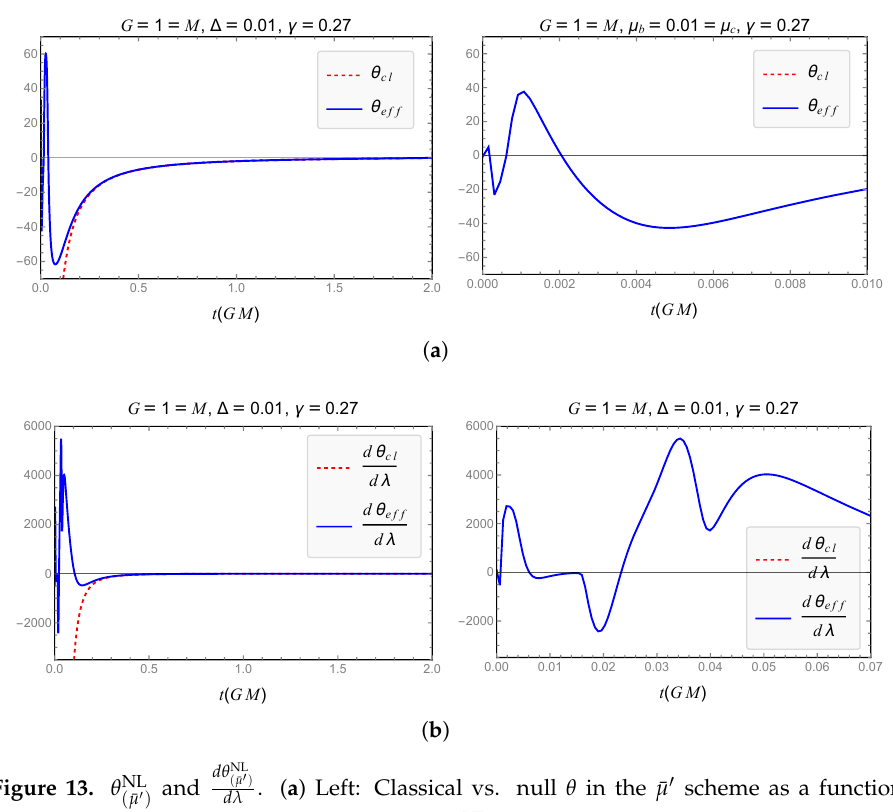
d θ NL ( ¯ µ (cid:48) ) Figure 13. θ NL and . ( a ) Left: Classical vs. null θ in the ¯ µ (cid:48) scheme as a function of the ( ¯ µ (cid:48) ) d λ Schwarzschild time t . The effective expansion θ NL goes to zero as t → 0. Right: Close up of the left ( ¯ µ (cid:48) ) figure close to t = 0. ( b ) Left: Classical vs. null d θ in the ¯ µ (cid:48) scheme as a function of the Schwarzschild d λ d θ NL ( ¯ µ (cid:48) ) time t . The effective goes to zero as t → 0. Right: Close up of the left figure close to t = 0. d λ The correction terms in this case are not all negative, although most of them are. It turns out that the full K behaves in the desired way. It stays finite everywhere and goes to zero for t = 0. This can be seen from Figure 14.